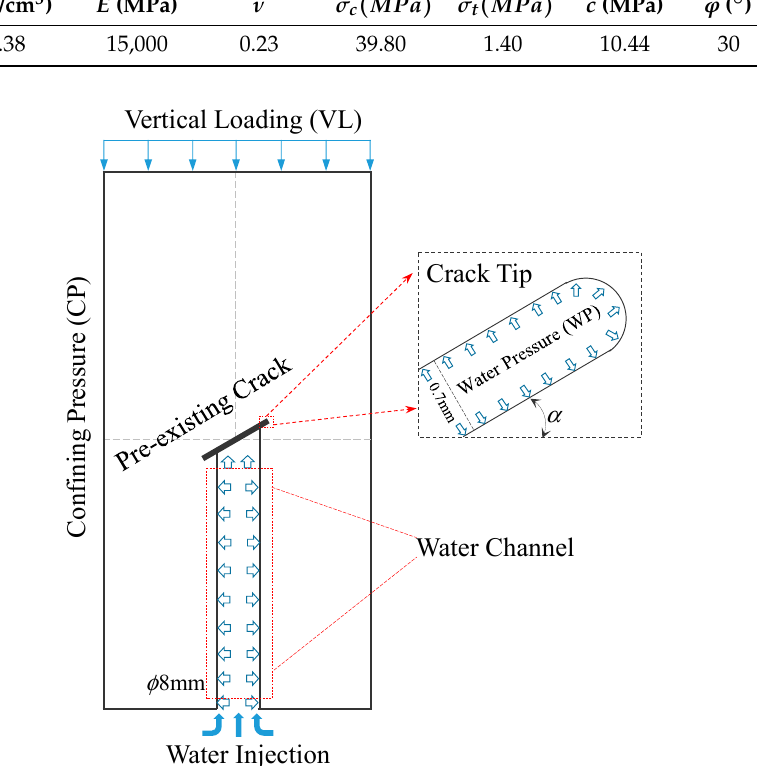
Figure 1. Loading conditions used in the hydraulic fracturing tests. Table 1. Specimen’s parameters.